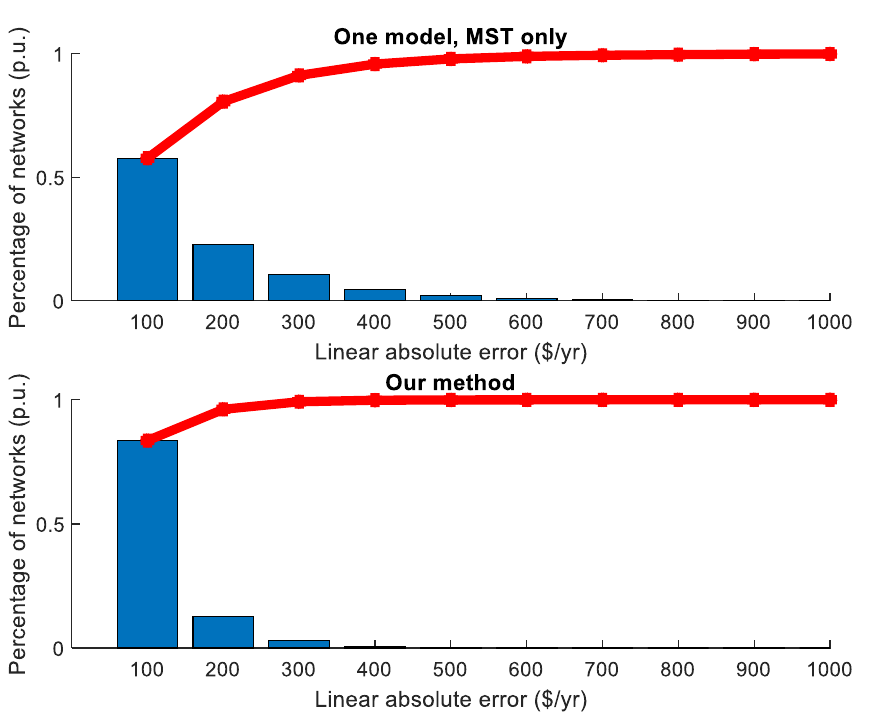
Figure 10. Linear relative error comparison.